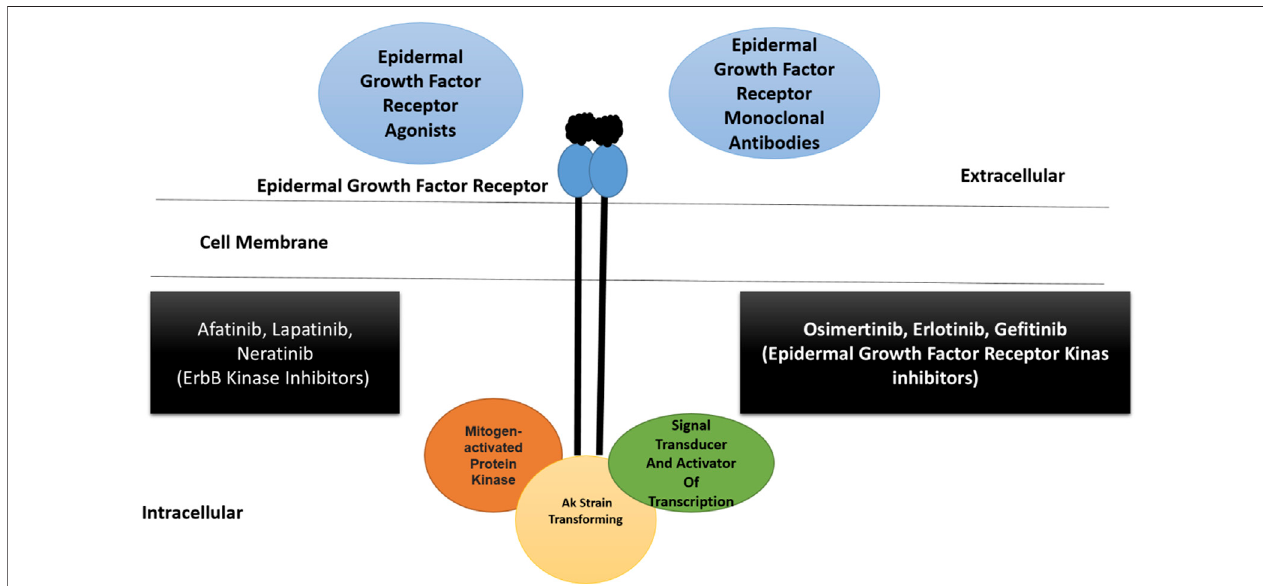
FIGURE 2 | A schematic illustration of epidermal growth factor receptor signaling pathway along with activators and inhibitors. The pathway is part of ErbB superfamily.Theepidermalgrowthfactorreceptorisabletobindtodifferentligandsattheextracellularsurfaceresultingintheactivationofdownstreamsignalingevents. Therapeutics including monoclonal antibodies and different kinase inhibitors can block the binding of ligand to the receptor. The kinase inhibitors can also block the function of other ErbB receptors (Ali and Wendt, 2017; Medina et al., 2020). Inhibitors of polyadenosine diphosphate-ribose polymerase.